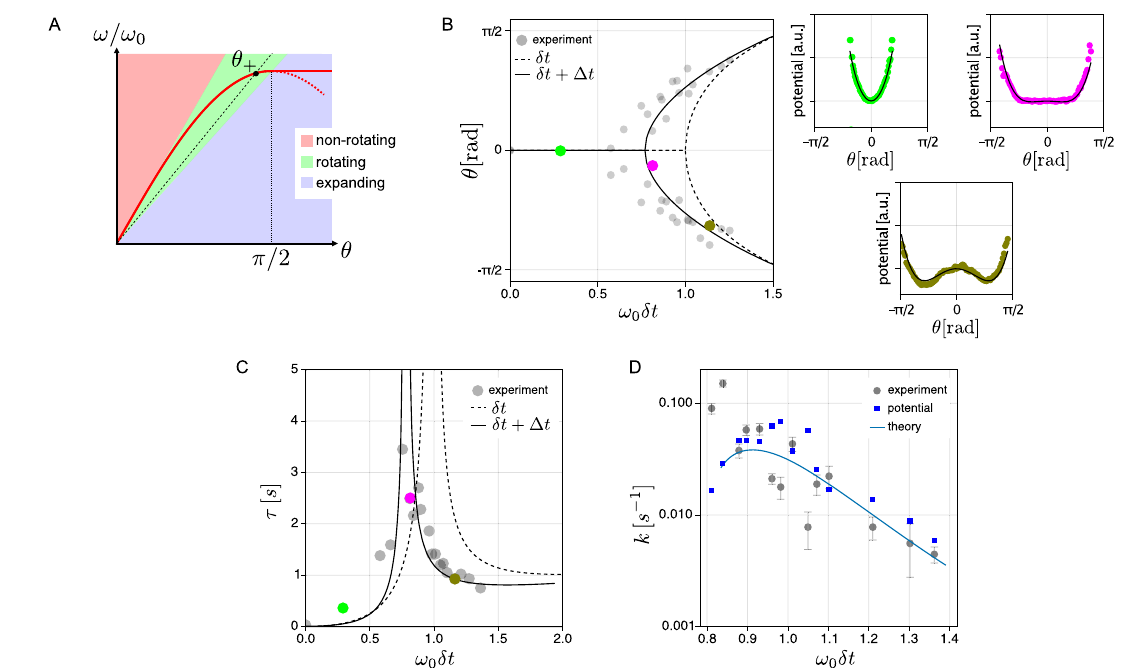
Fig. 3 | Transition to a rotational dynamical state for a single active particle. A Graphical construction of condition (3) for a transition from an non-rotational state (red-shaded region) to a rotational state (green-shaded region). The red line (sin θ ) and the black dashed line with slope 1/( ω 0 δ t ) intersect at several θ . The solution θ = θ + in the green region and its chirally inverse image θ − in the third quadrant (not shown) correspond to co- and counter-clockwise rotation. B Experimentally measured propulsion angles (maxima of the histograms in Fig. 2C) as a function of ω 0 δ t , exhibiting a bifurcation at ω 0 δ t ≈ 0.76. The dashed line corresponds to the analytical prediction of the theoretical model (5), neglectingtheinevitableinstrumentaldelay Δ t .Thesolidlineshowsthesolutionof the re fi nedtheoretical model,which includes the instrumentaldelay Δ t =64ms of our setup in addition to the programmed delay δ t . The colored dots indicate